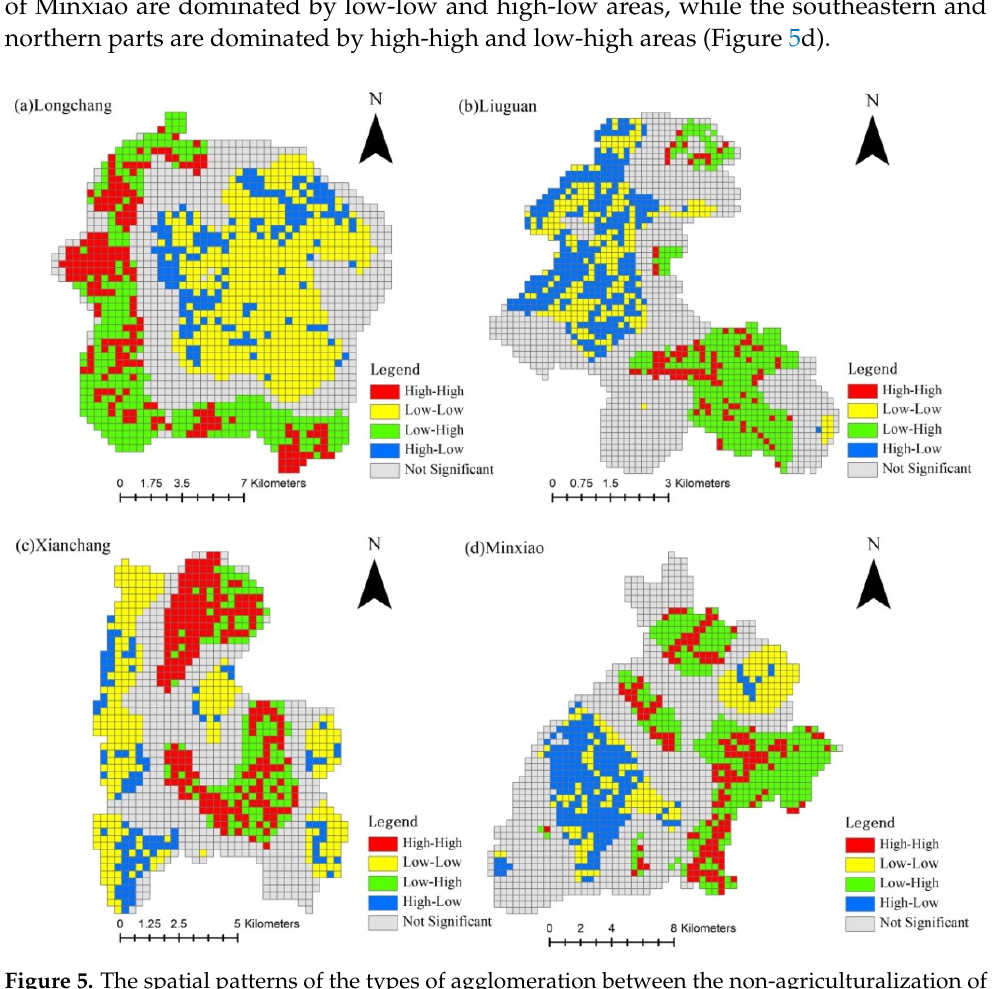
Figure 5. The spatial patterns of the types of agglomeration between the non-agriculturalization of cultivated land and landscape ecological risk. ( a ) Longchang, ( b ) Liuguan, ( c ) Xianchang, ( d ) Minxiao.